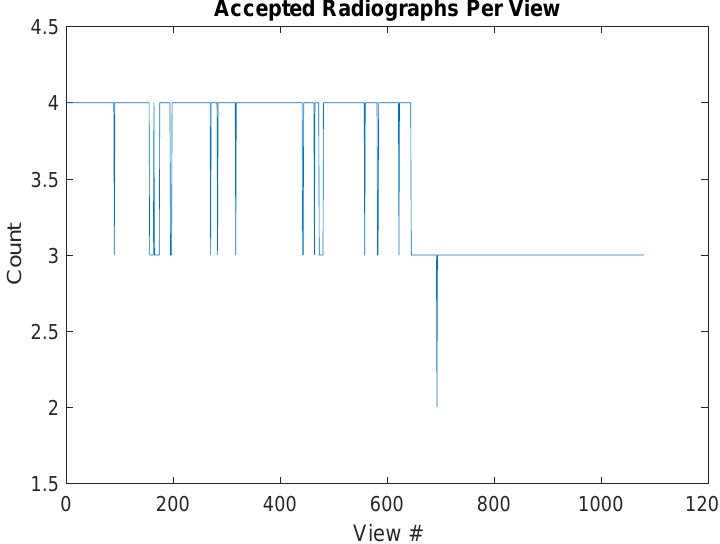
Figure 5. The number of radiographs per view is presented above. Note that even after filtering results for beam dropout and large beam fluctuation, the full set of 1080 views is adequately